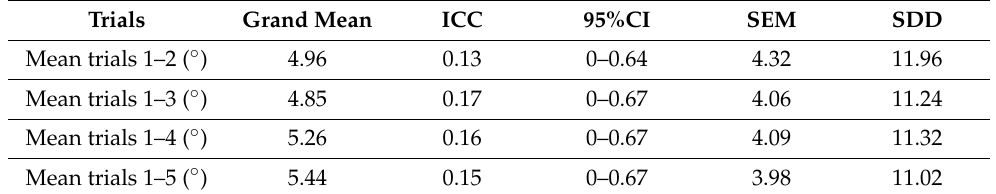
Table 4. Test-retest reliability of the double inclinometer method for the assessment of thoracolumbar joint position sense.